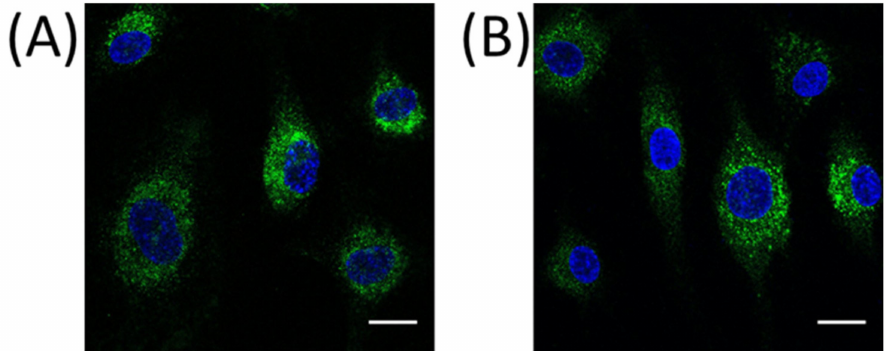
Figure 3. PRCP is observed in cytoplasmatic vesicular structures of HUVEC and HAoEC. Immunoflu- orescent staining of PRCP in HUVEC ( A ) and HAoEC ( B ). Cells were fixed with 4% paraformaldehyde (PFA), permeabilized with 0.1% Triton X-100 and stained for PRCP (green) and DAPI (nuclear marker, blue). (bar = 20 µ